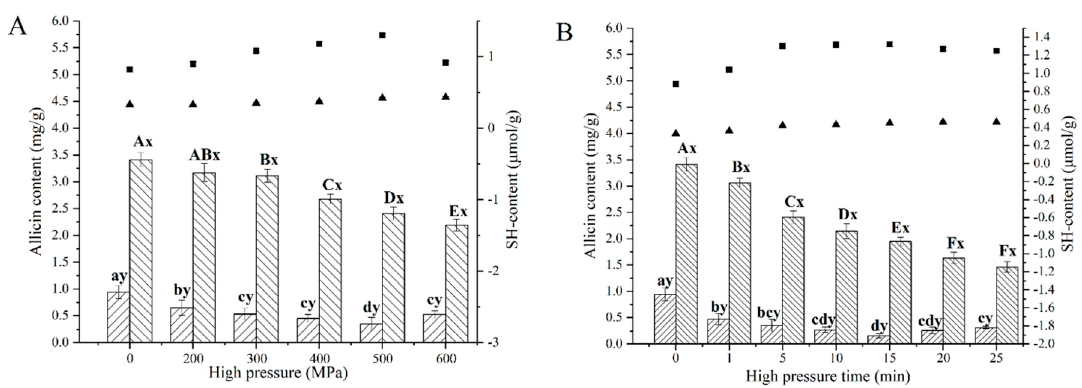
Figure 4. Effect of ( A ) HHP and ( B ) pressure holding time at 500 MPa on the contents of allicin and Figure 4. E ff ect of ( A ) HHP and ( B ) pressure holding time at 500 MPa on the contents of allicin and Figure 4. E ff ect of ( A ) HHP and ( B ) pressure holding time at 500 MPa on the contents of allicin and Figure 4. E ff ect of ( A ) HHP and ( B ) pressure holding time at 500 MPa on the contents of allicin and thiol groups. represents allicin content in HHP-WP; represents allicin content in HHP- thiol groups. represents allicin content in HHP-WP; represents allicin content in thiol groups. thiol groups. represents allicin content in HHP-WP; represents allicin content in HHP-